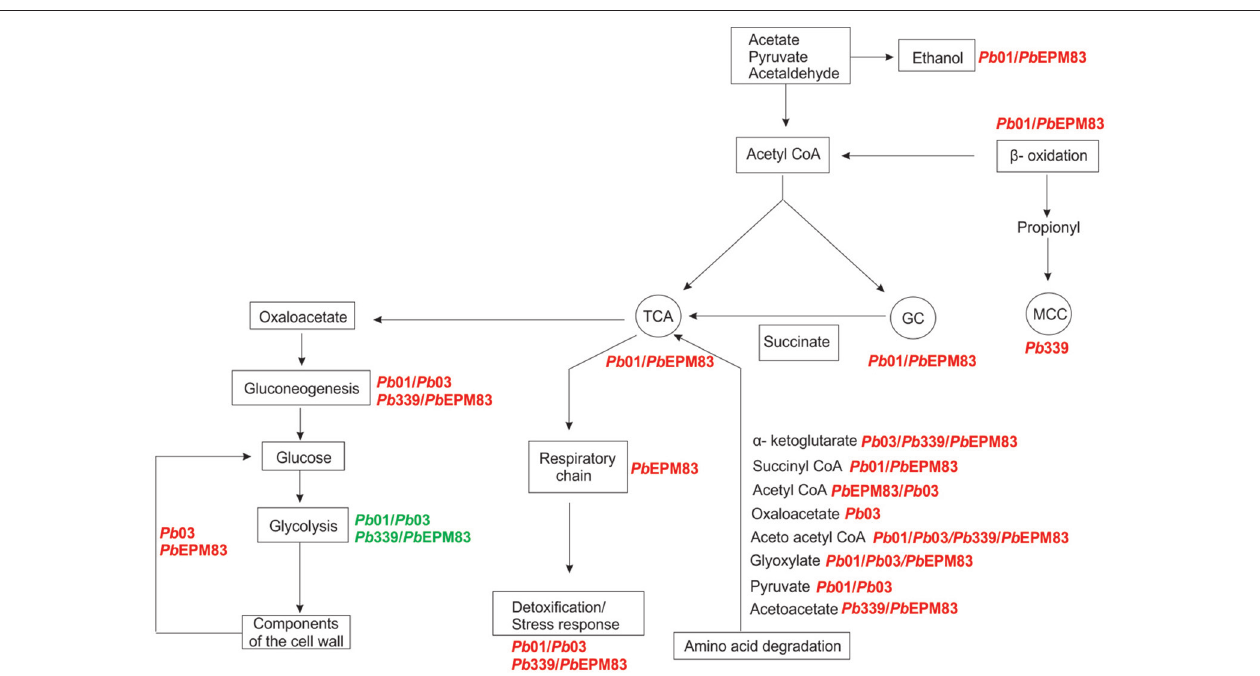
FIGURE 9 | Overview of metabolic features of members of the Paracoccidioides genus in sodium acetate as carbon source. The metabolic pathways were identified by analyzing up-regulated proteins in P. lutzii ( Pb 01) and P. brasiliensis Pb 03, Pb 339, and Pb EPM83. The main metabolic pathways were represented: gluconeogenesis, fermentation, cycles of the tricarboxylic acid (TCA), glyoxylate (GC) and methyl citrate (MCC), respiratory chain, β - oxidation, amino acid degradation, detoxification/response to stress, and cell wall